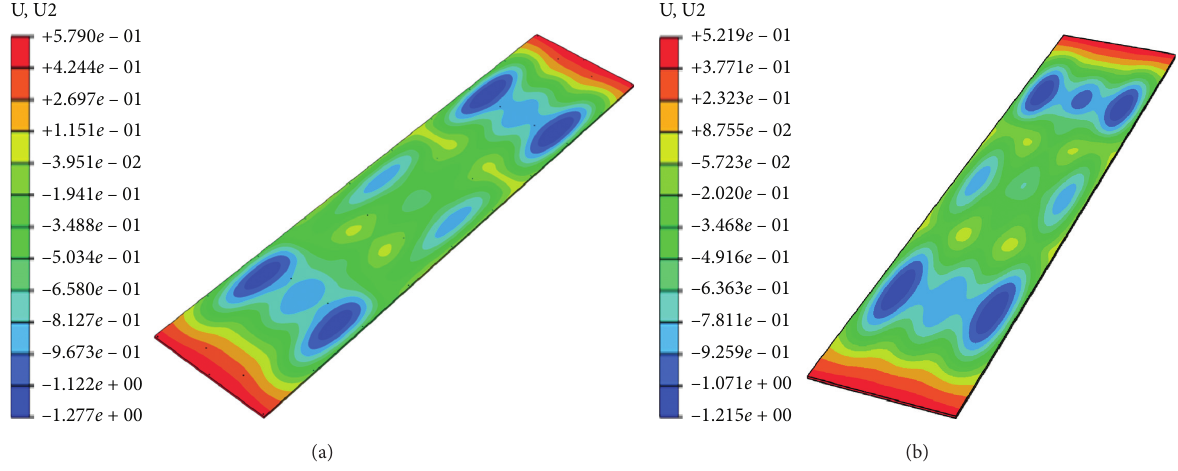
Figure 25: Deflections of the template (unit: mm). (a) Refined model. (b) General model.